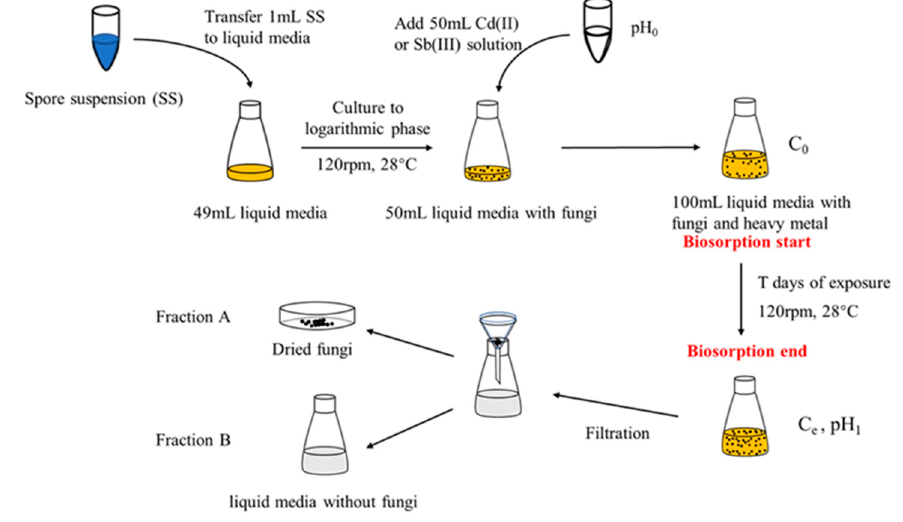
Figure 1. Schematic diagram of adsorption experiments of XK10 .